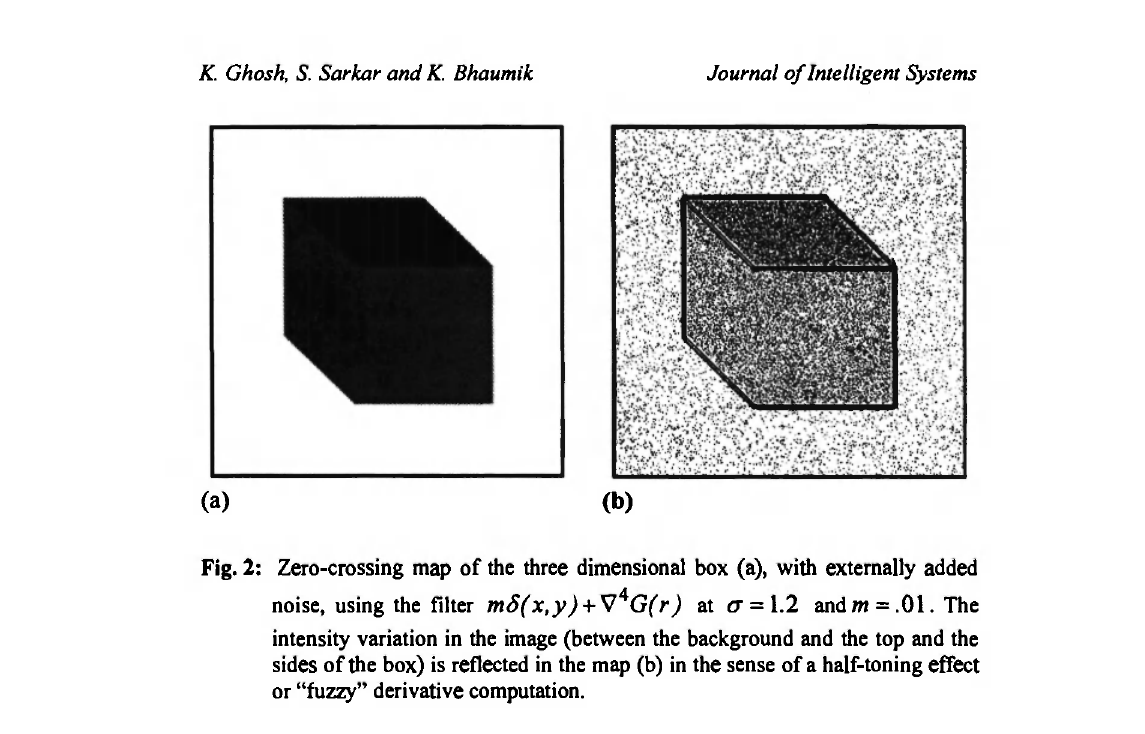
Fig. 2: Zero-crossing map of the three dimensional box (a), with externally added noise, using the filter mS(x,y) + V 4 G(r) at σ = 1.2 and m = . 01. The intensity variation in the image (between the background and the top and the sides of the box) is reflected in the map (b) in the sense of a half-toning effect or "fuzzy" derivative